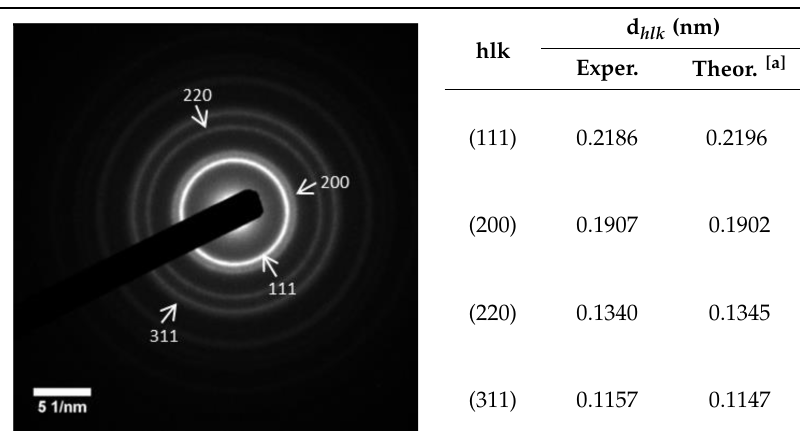
Table 2. Electron di ff raction pattern of M2